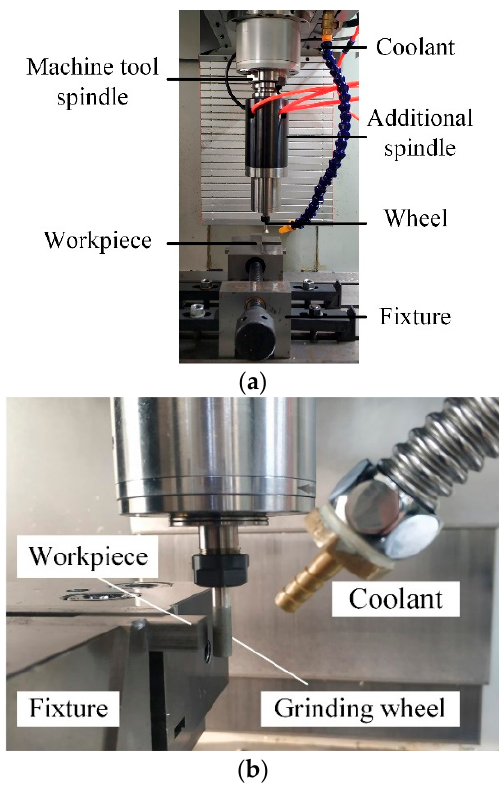
Figure 3. Additional high-speed spindle. ( a ) High-speed spindle, ( b ) Machining setup.